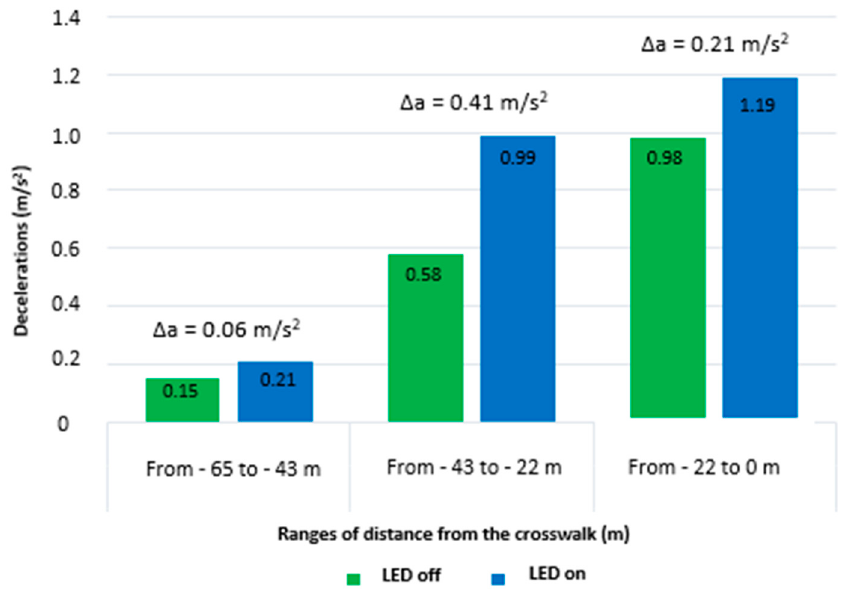
Figure 8. Deceleration analysis over three distance ranges.